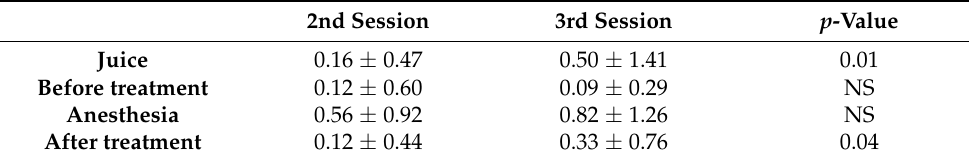
Table 5. Comparison of Venham scores of the 1st and 3rd session ( n = 25).